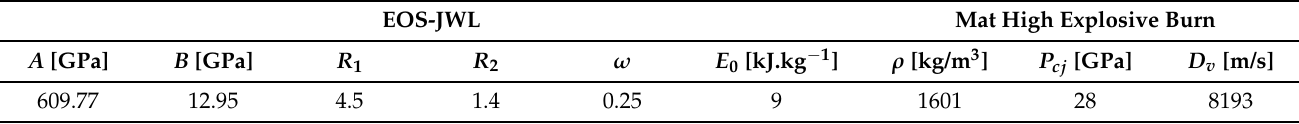
Table 3. Explosive material properties and EOS parameters.